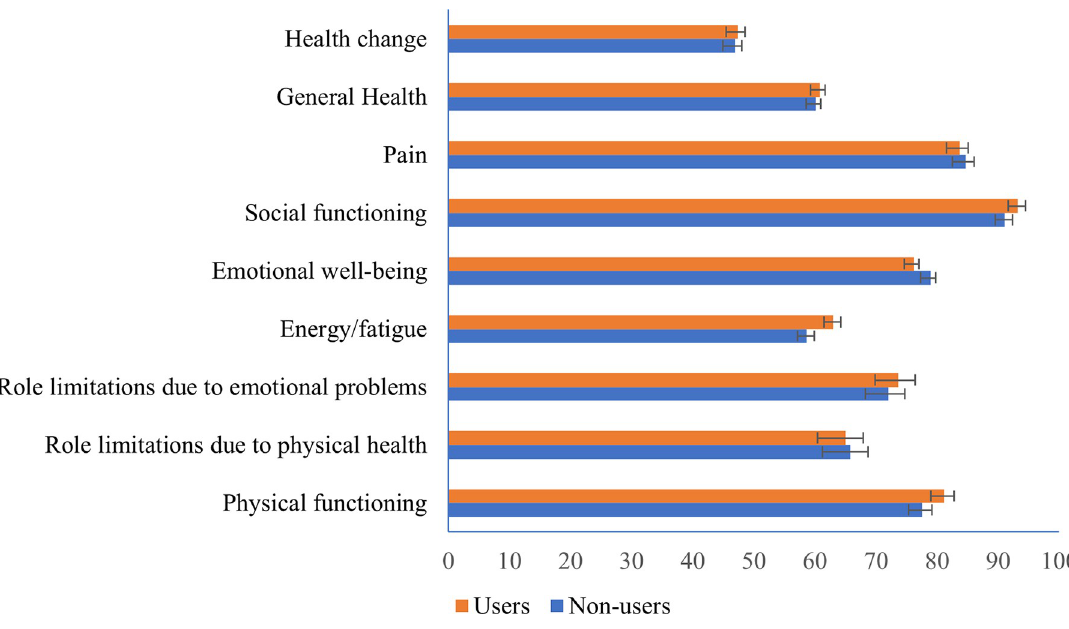
Fig 1. Mean scores of HRQOL domains for crude herb users and